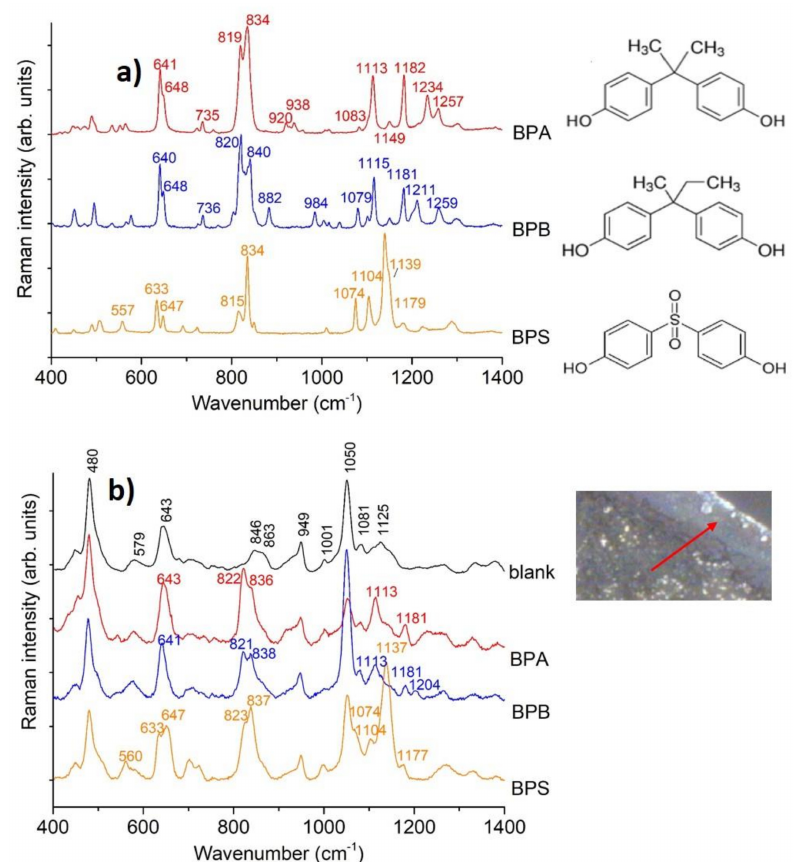
Figure 1. ( a ) Raman spectra of solid BPs (laser power 1 mW, exposure 50 s, 5 accumulations). ( b ) SERS spectra measured on dried droplets with BPs and AgNPs-SH-CD (analyte concentration 2.5 × 10 − 5 M). The arrow in the inset shows the droplet region where the measure was performed (photo taken with the 60 × objective and instrument camera). Raman intensities were normalized with respect to the 480 cm − 1 band of CD-SH (laser power 0.3 mW).